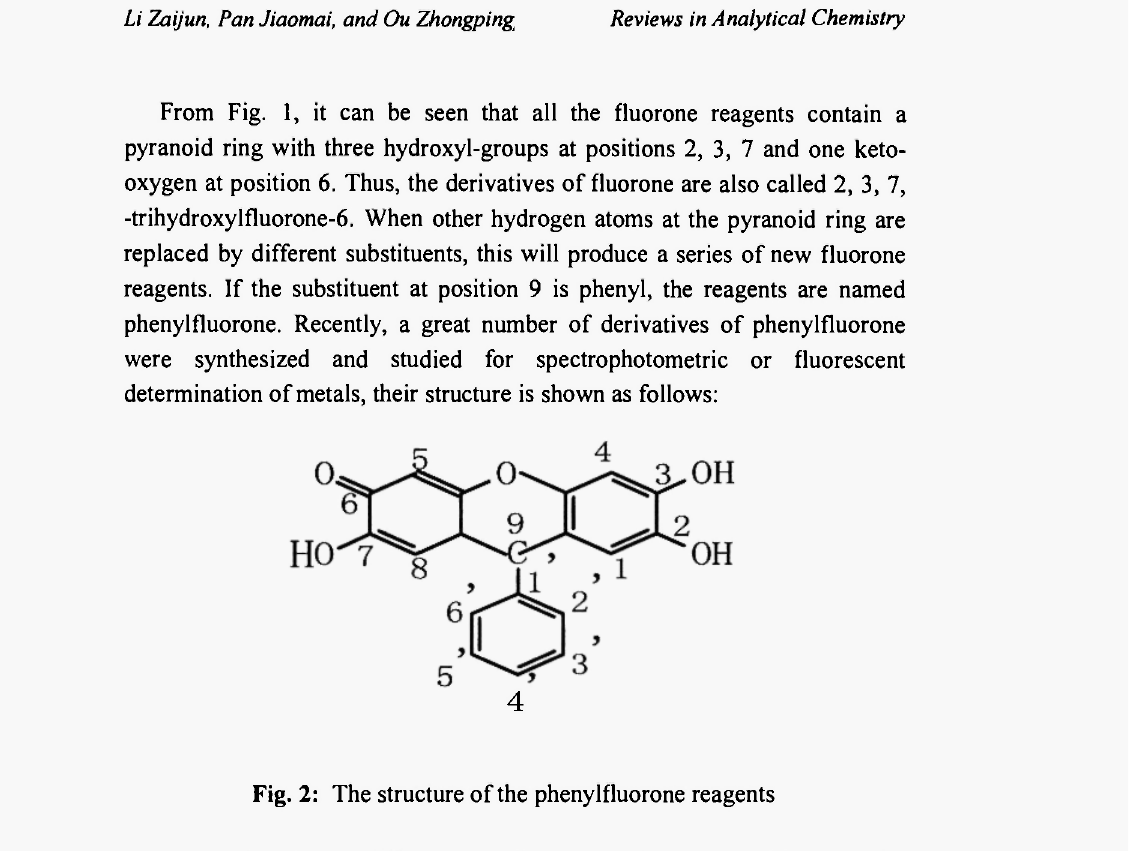
Fig. 2: The structure of the phenylfluorone